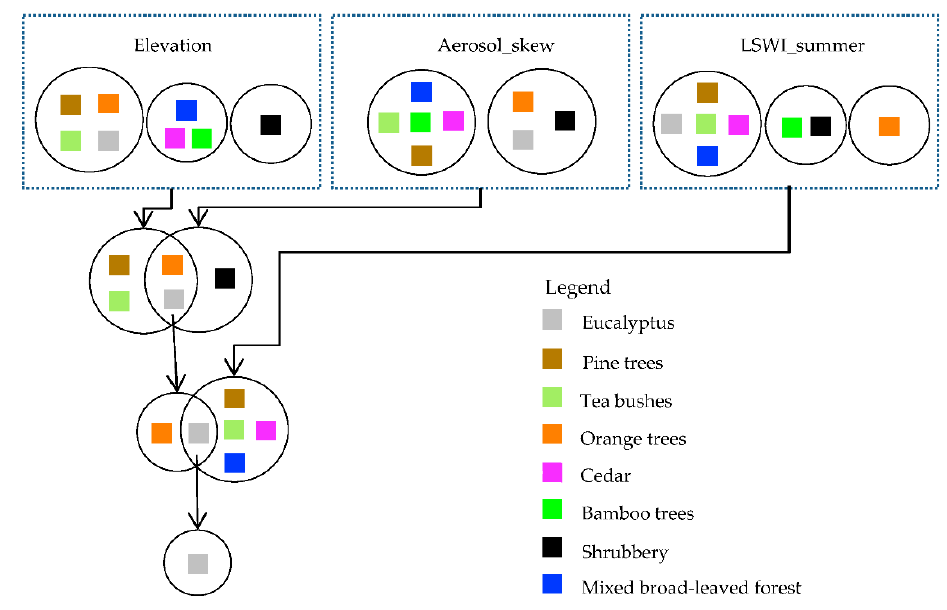
Figure 6. Results of the classification of tree species by different algorithms based on the optimal feature variables.